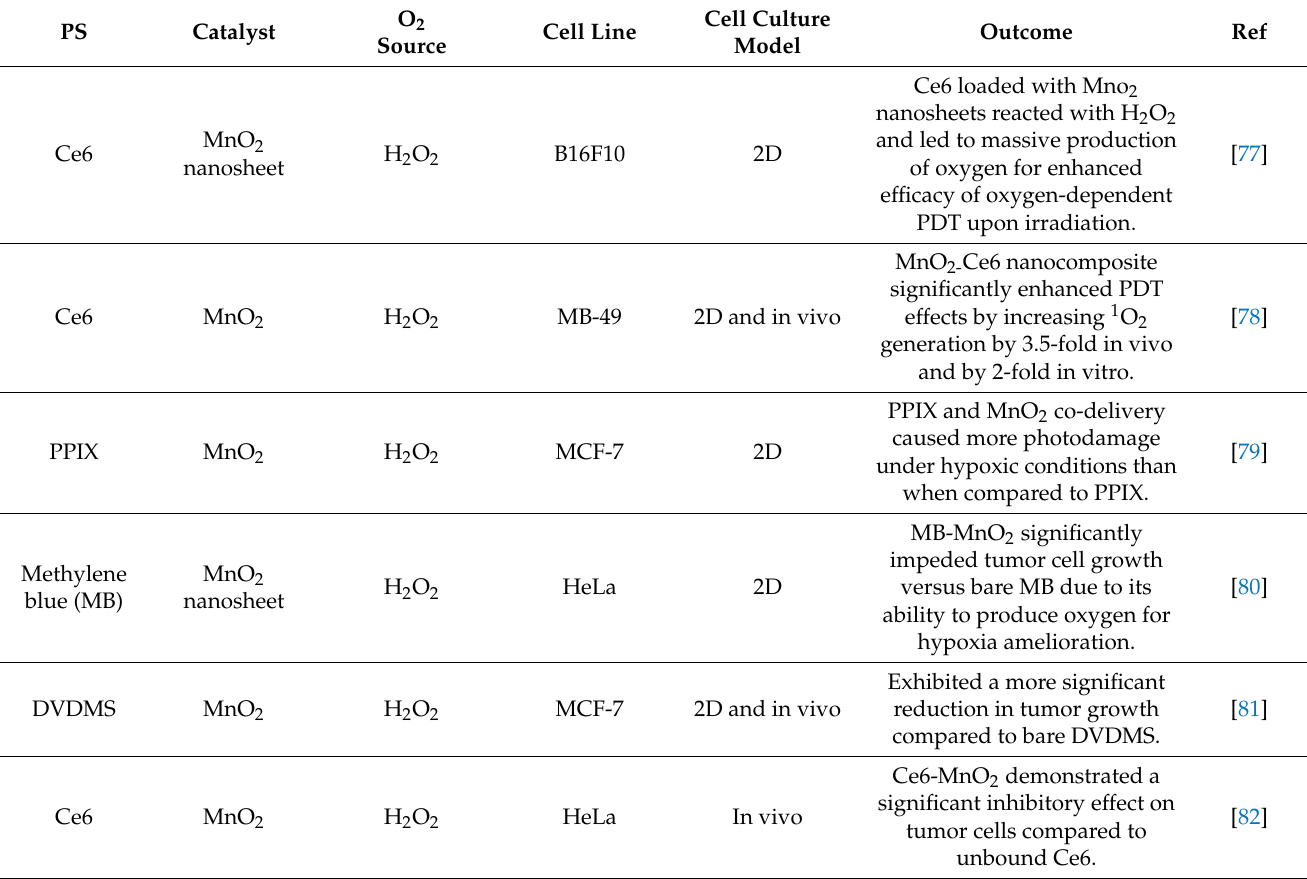
Table 4. An overview of studies that used MnO 2 to decompose H 2 O 2